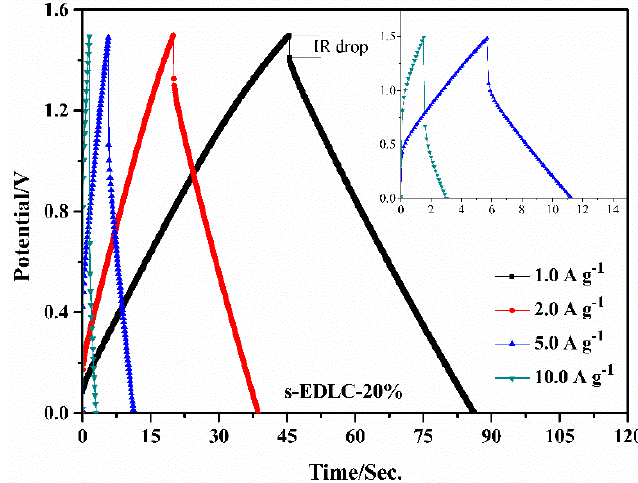
Figure 6. GCD profiles of the solid-state supercapacitor s-EDLC-20% at various current densities (1.0–10.0 A · g − 1 ) with the GCD curves at 5.0 A · g − 1 and 10.0 A · g − 1 in the inset.